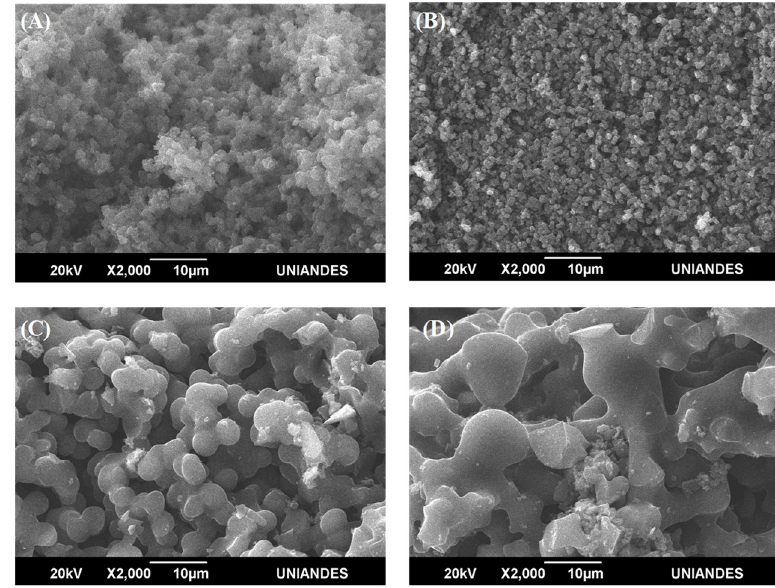
Figure 4. SEM micrographs of: ( A ) ACB 1050; ( B ) AAB 850; ( C ) ACA 1050 and ( D ) AAA 850.